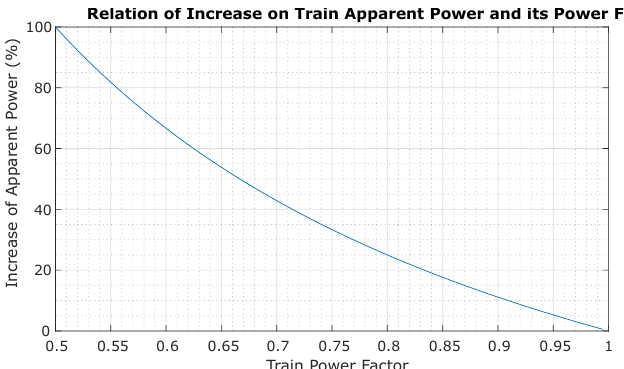
Figure 16. Relation of changing power factor, from unitary one, with an increase of train apparent power.